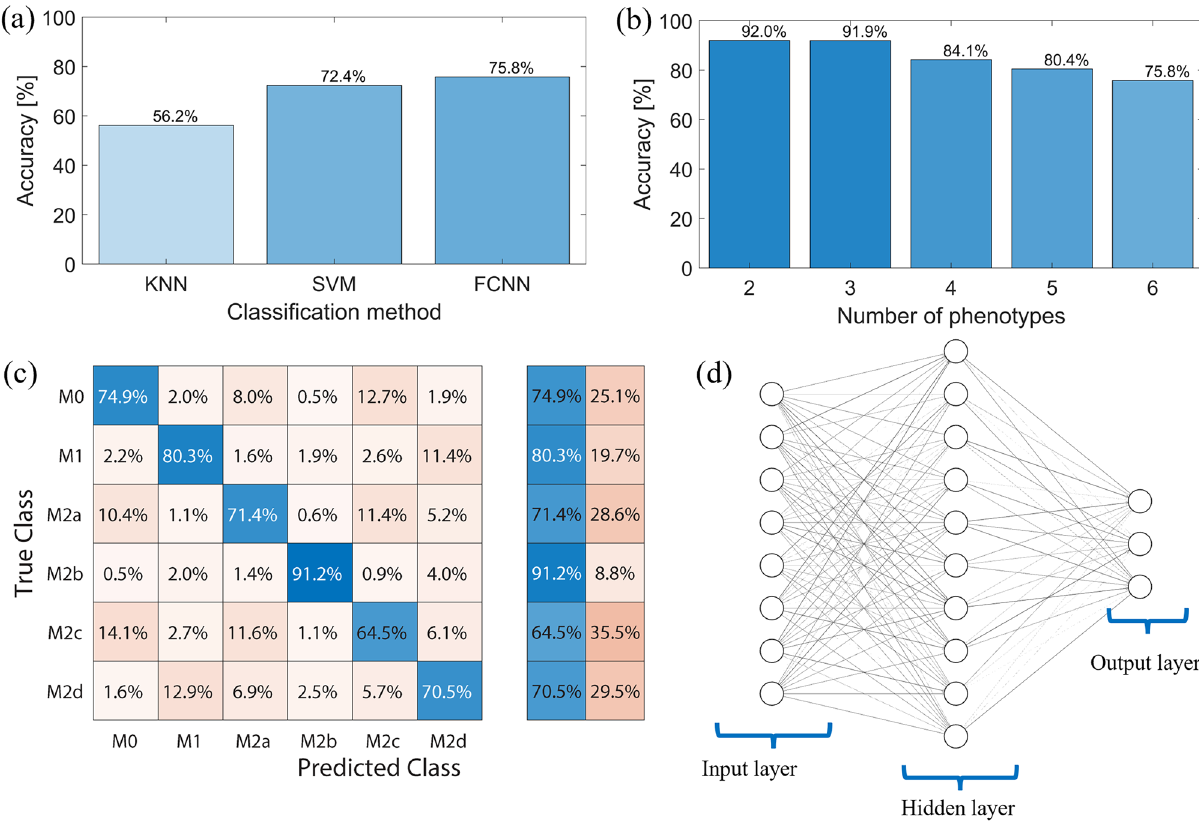
Figure 5. Label-free macrophage classification accuracy. ( a ) Classification accuracy using KNN, SVM and FCNN classifiers tested for their ability to classify the six macrophage phenotypes, where the FCNN is noted to provide the highest classification accuracy. ( b ) The classification accuracy of any 2, 3, 4, 5 phenotypes combinations, comparing to the 6 phenotypes. ( c ) The confusion matrix representing the accuracy of macrophage phenotyping using intrinsic autofluorescence. In blue are the correctly identified cells, while phenotypes not correctly identified are in pale red. Difference in color intensity is indicative for numerical values with darker shades representing higher values. The table on the right demonstrates overall summary for correctly and not correctly identified cells (i.e., true positives and false positive). ( d ) A representation of the utilized Fully Connected Neural Network (FCNN) architecture with a single wide hidden layer. The number of neurons in the figure are for illustration only, the actual utilized number is 45 for the input, 100 for the hidden layer, and 6 for the output as it will be further explained in the “Detailed methods and data analysis”